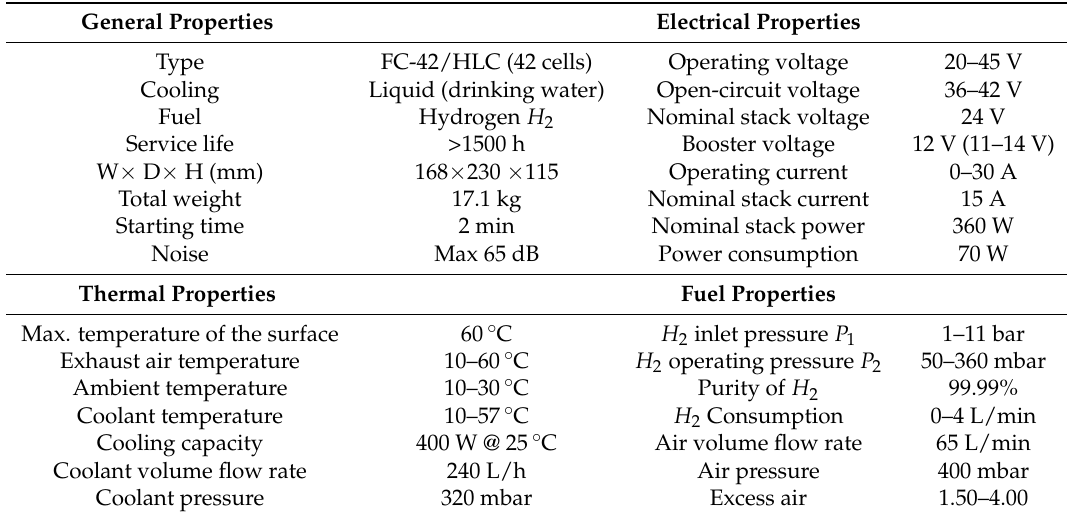
Table 3. Technical data of the FC-42 Evaluation